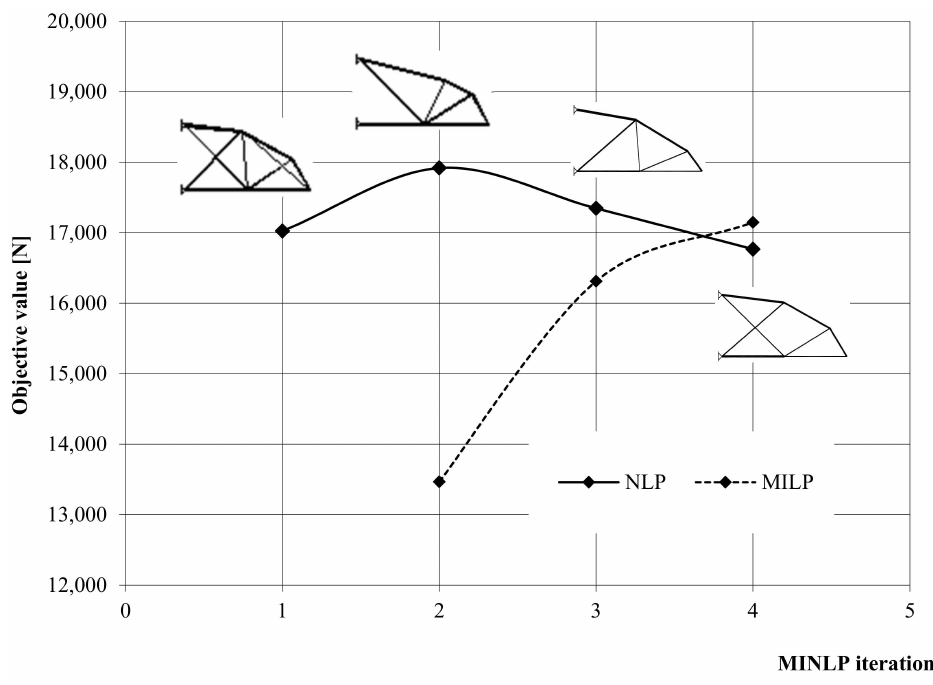
Figure 8. Convergence to the optimal topology (initial MINLP phase of the MTP strategy), example TC10b (topology and shape optimization, without buckling constraints).